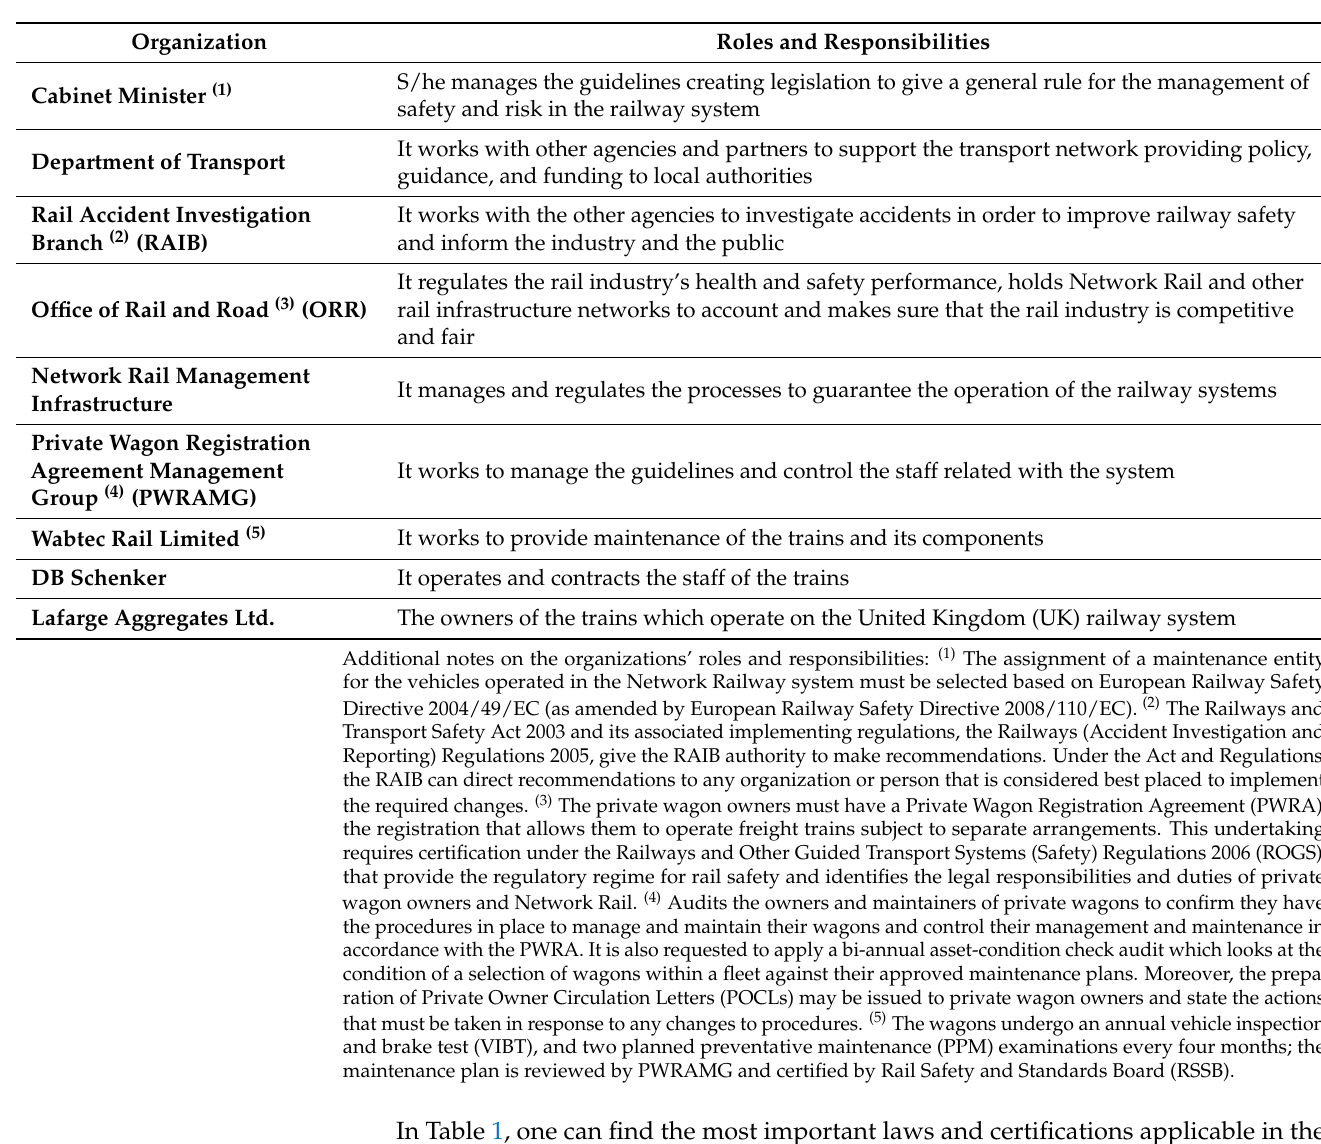
Table 1. Organizations responsibilities and roles involved in the